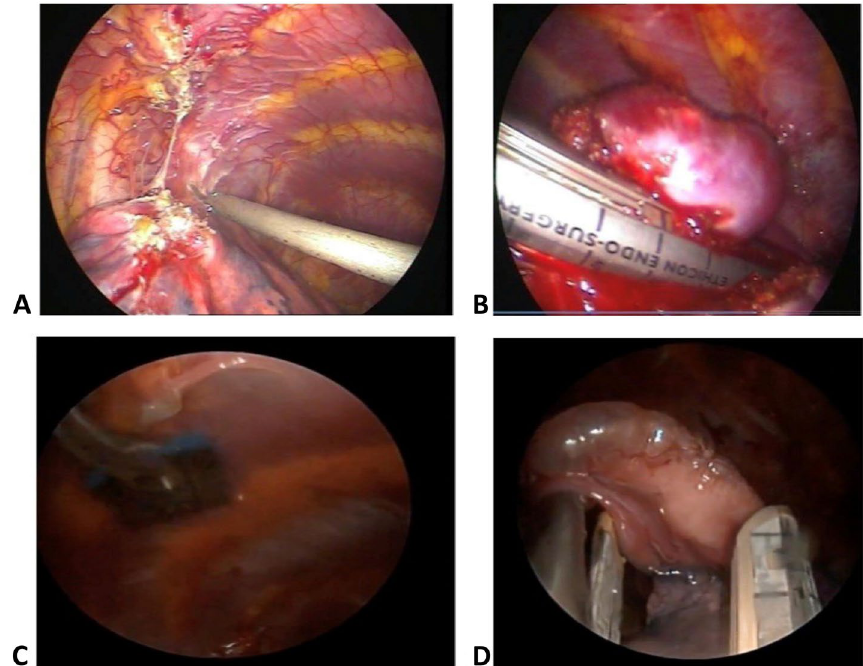
Fig. 2 VATS bullectomy by stapler technique:‑. A Breaking the adhesion and freeing of lung from chest wall. B Grasping bulla by lung grasping forceps and putting the stapler below the bulla. C Firing the stapler and exploring the stapler line for air leak and bleeding. D Apical pleural abrasion for pleurodesis via diathermy scratch pad over a long clamp. Some patients (26.7%) were done by